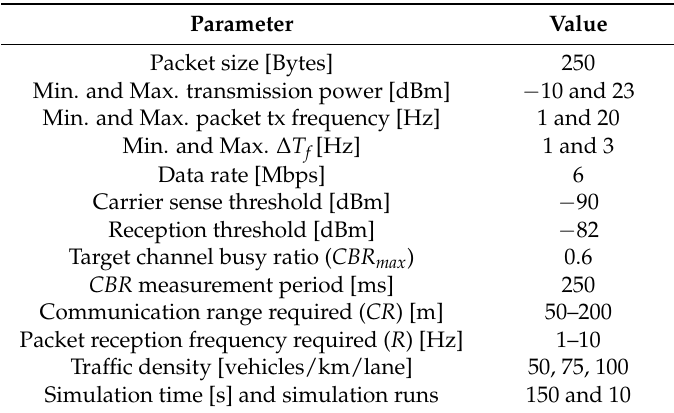
Table 1. Communications and simulation